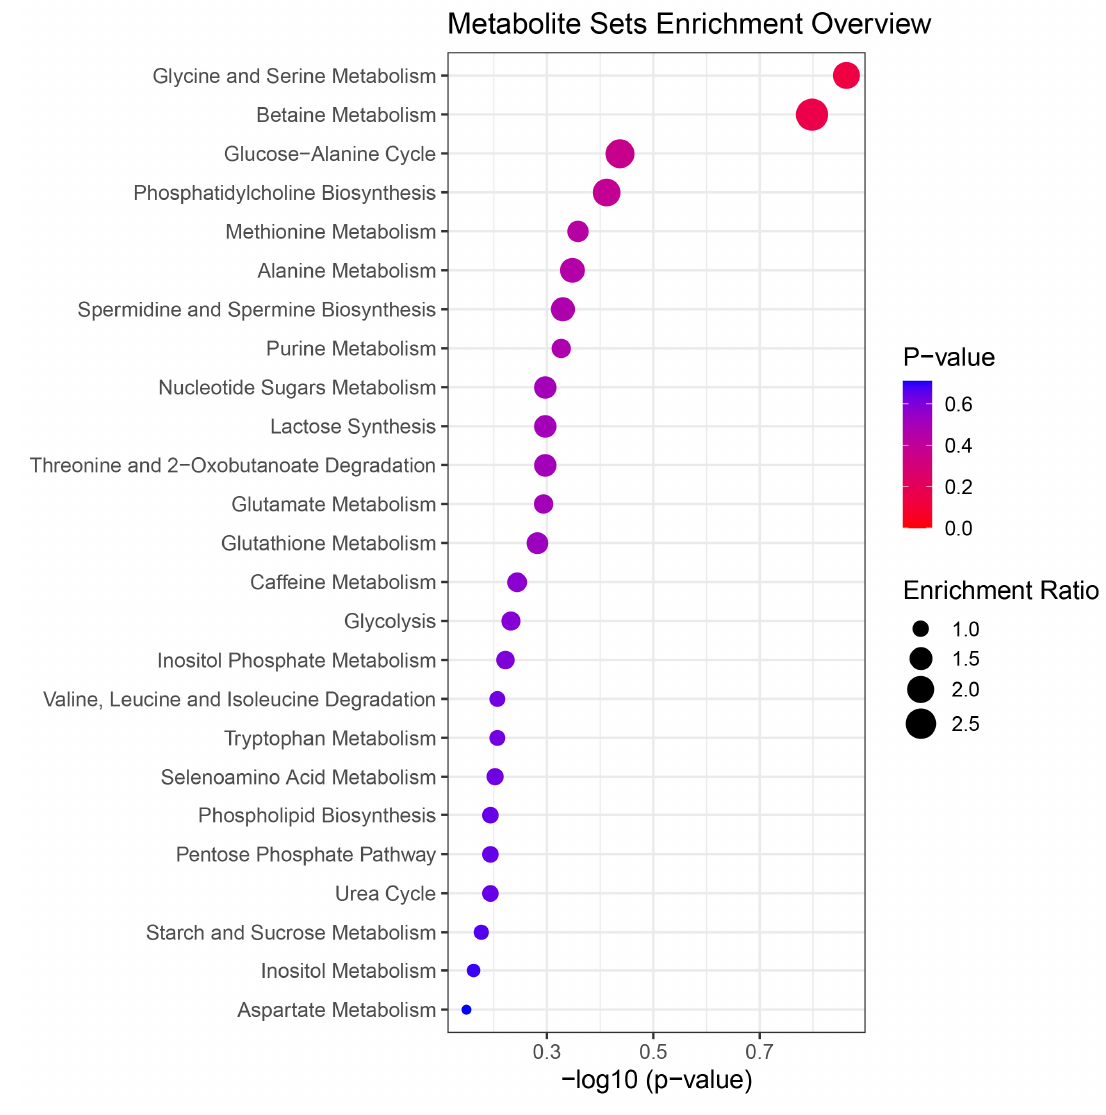
Figure 5. Pathway analysis of the 37 potential metabolic biomarkers. The node size is proportional to the enrichment ratio. The color from red to purple indicates p values from small to large.